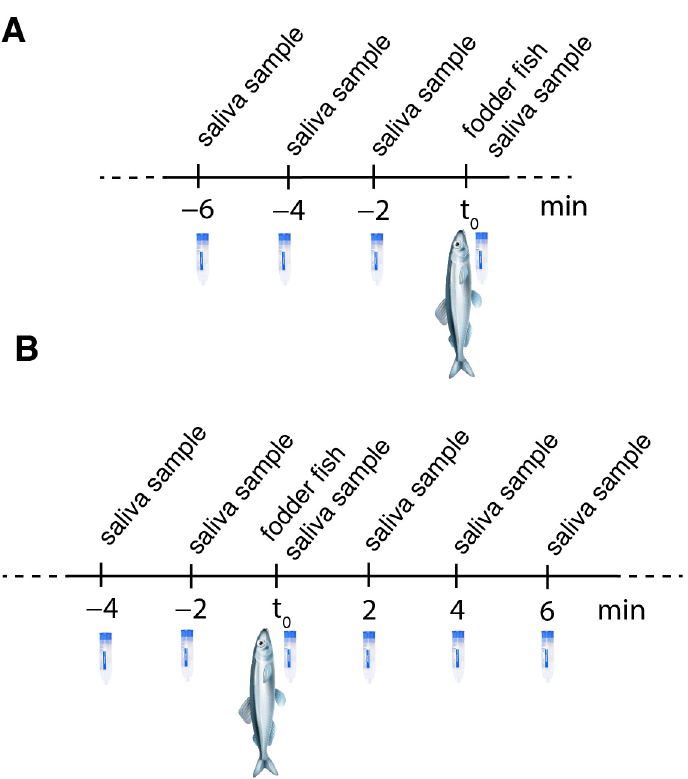
Figure 4. Fixed saliva sampling schemes used for ( A ) feeding experiment I and ( B ) feeding experi- ment II.